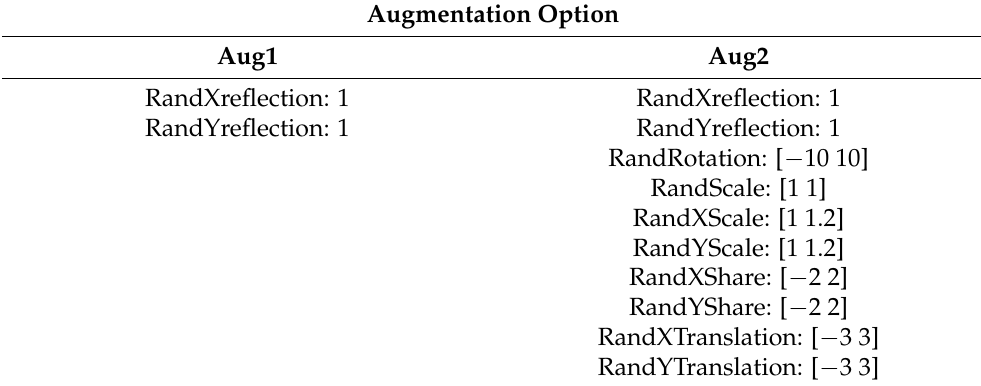
Table 2. Augmentation option for comparative analysis.